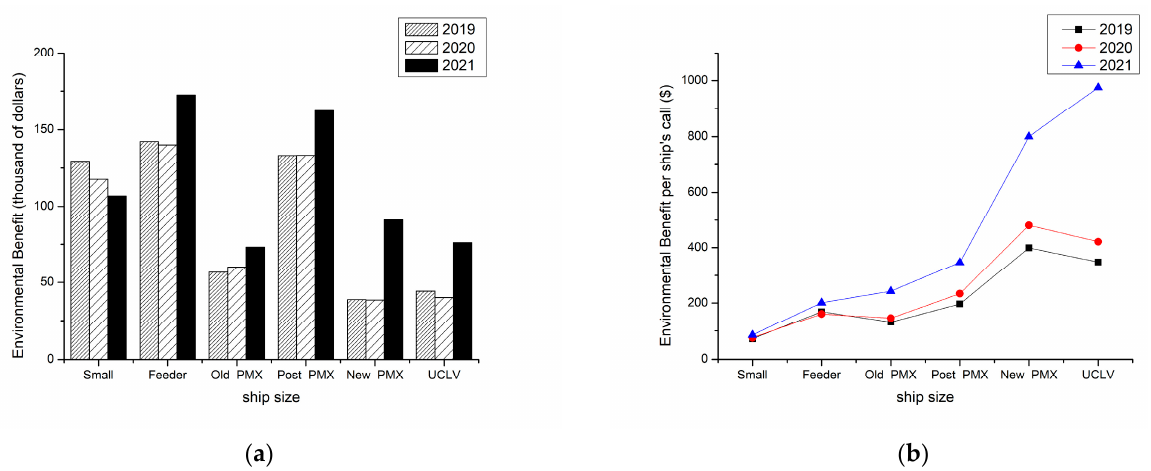
Figure 6. (a ) Environmental benefit and ( b ) environmental benefit per ship’s call.